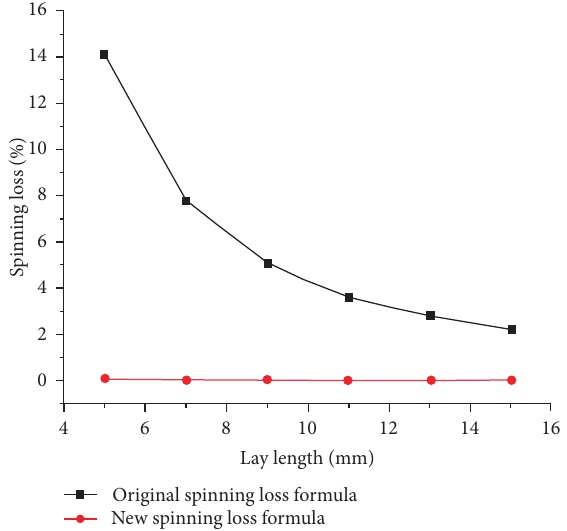
Figure 11: 0.28+6 × 0.26 steel cord new and old formula to make a spinning loss result comparison.